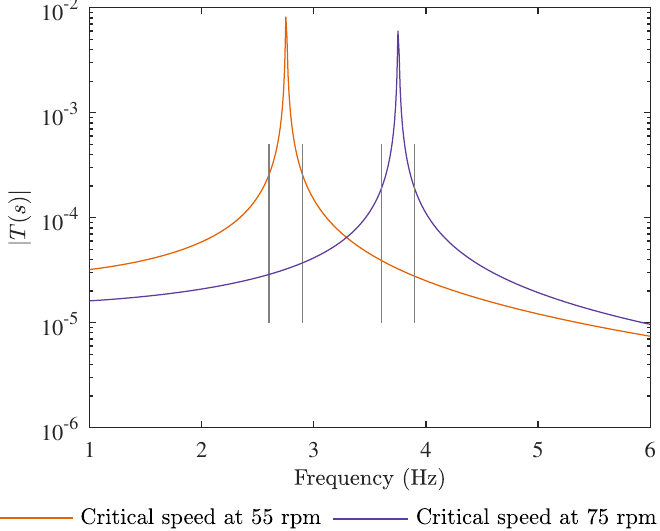
Figure 5. Frequency response of the fictive tower model (14) for a critical speed at 55rpm and 75rpm. The corresponding critical range of ± 3rpm is also